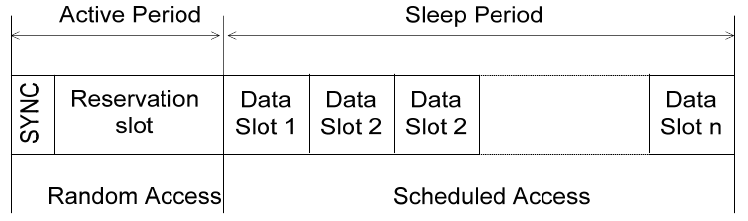
Figure 2. Frame structure for the proposed Efficient MAC with Parallel Transmission (EP-MAC) protocol.